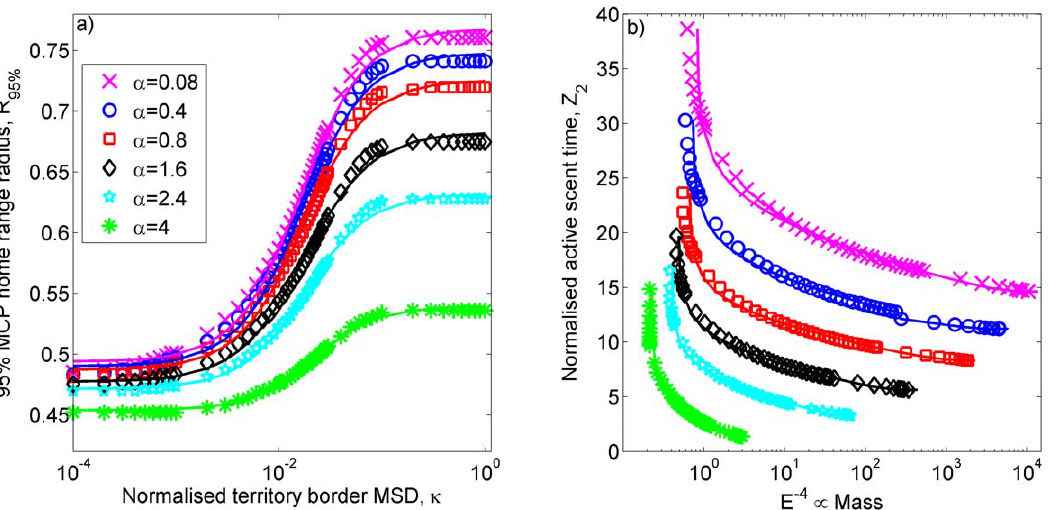
Figure 4. Home ranges and allometry. Panel (a) shows how the radius R 95% of the normalised (by dividing by the mean distance between CPs) 95% minimum convex polygon home range depends on k and a in the 2D analytic model. The various shapes (circles, squares, crosses etc.) show the exact values and the solid lines show the least-squares best-fit sigmoidal curves. Notice that whenever R 95% v 0 : 5 , a buffer zone appears between scales with mass [13] so this value is plotted in panel (b) against the adjacent territories. The proportion of exclusive area E ~ (1 { R 95% ) 2 = R 2 95% dimensionless parameter Z 2 ~ T AS D r for various a . Again, solid lines are derived from the best-fit sigmoidal curves whilst the points denoted by various shapes show exact values.